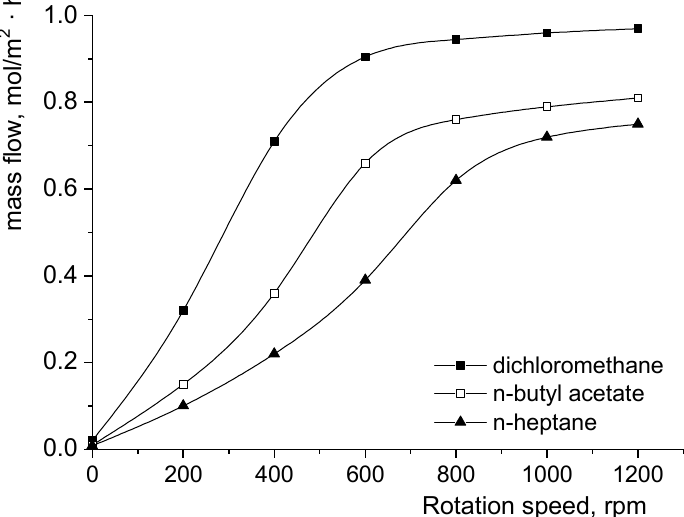
Figure 5. Influence of the impellers’ rotation speed on the fumaric acid mass flow from the pure aqueous phase to the organic phase with 1 ‐ octanol.